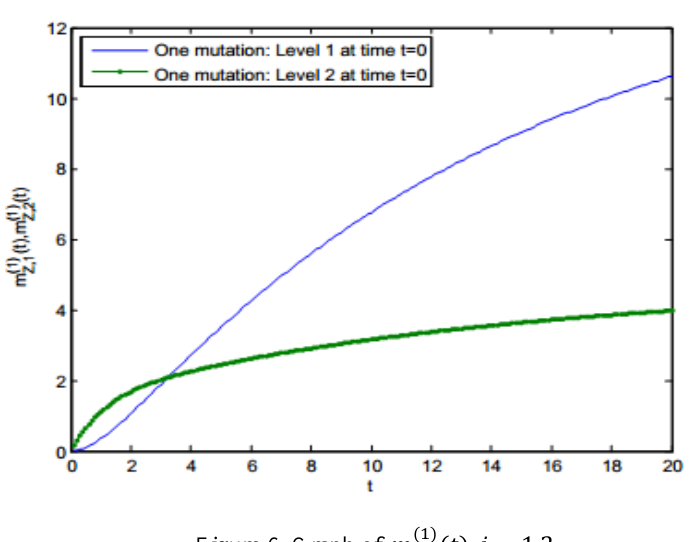
Figure 6. Graph of 𝑚 𝑍,𝑗(1) (𝑡), 𝑗 =